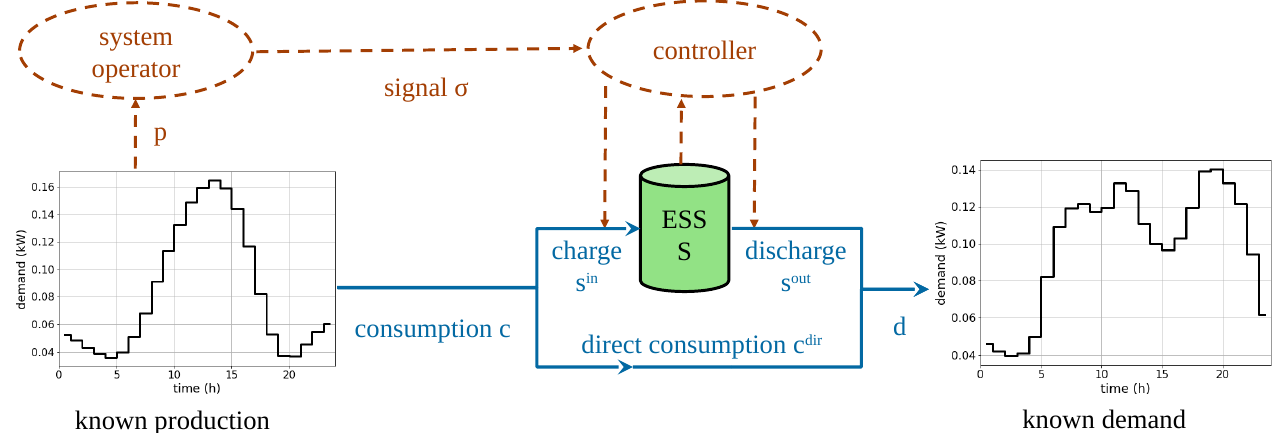
Figure 1. Energy system model: the power transfers between electric utility, ESS and household demand are indicated as solid lines. The dashed lines indicate signal communication (the signal which the electric utility sends to the household and the controller